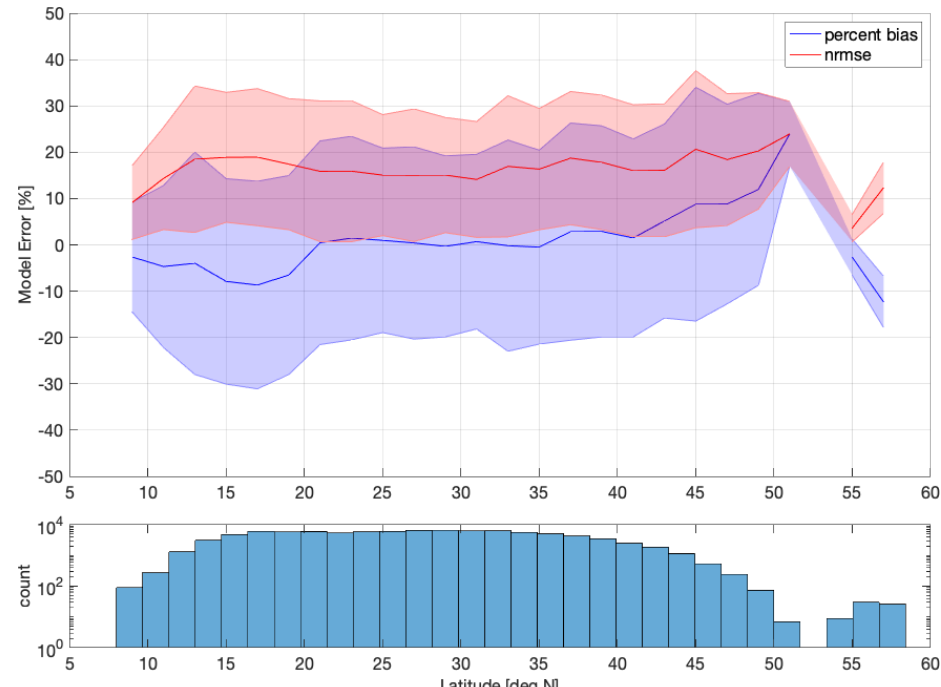
Figure 10. As in Figure 6 over 2° latitude